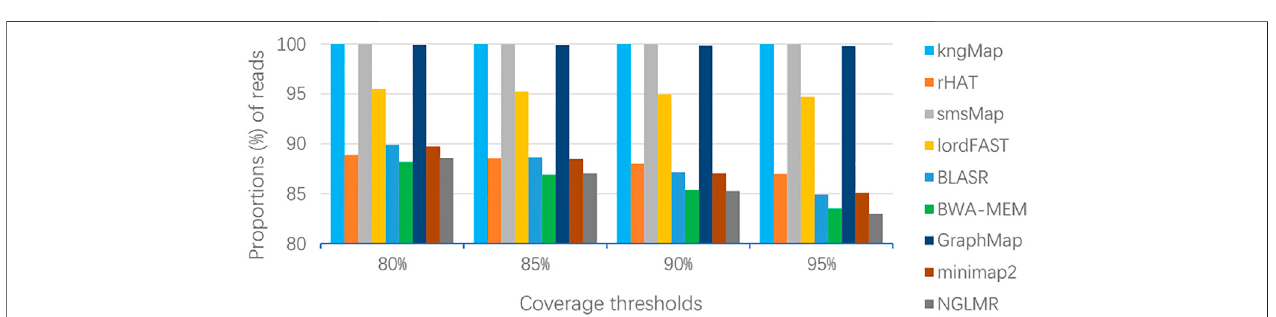
Frontiers in Genetics |